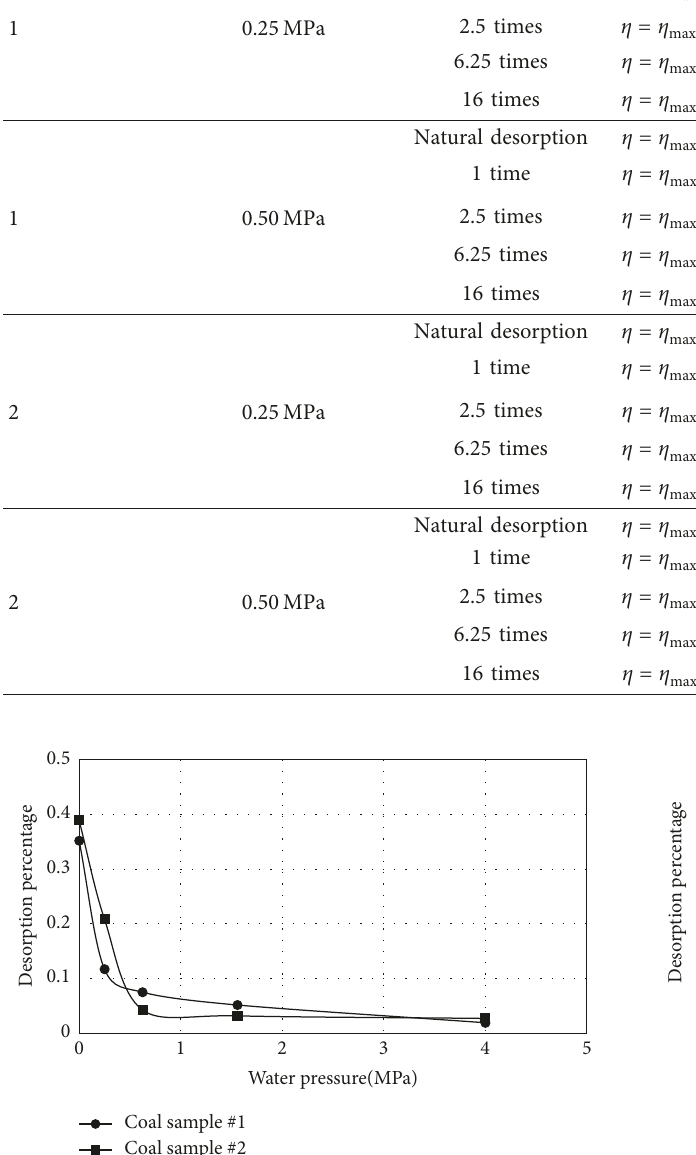
Figure 5: Desorption capacity as a function of water pressure for the two coal samples at 0.25 MPa gas adsorption pressure.